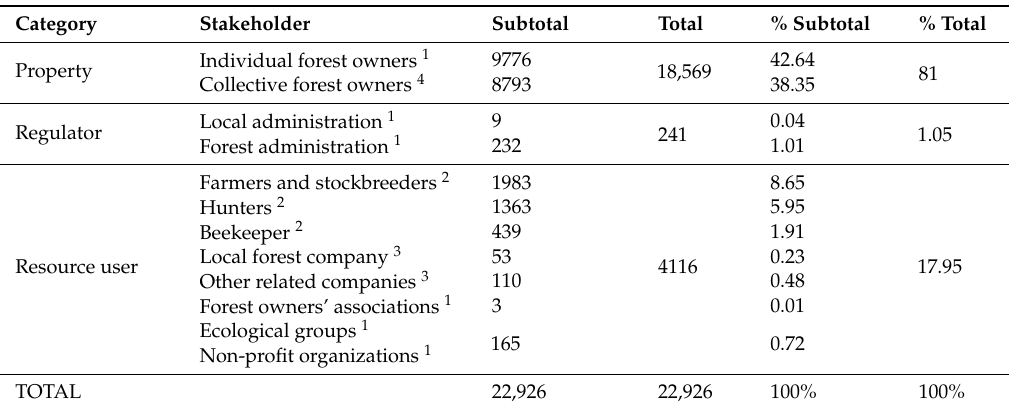
Table 2. Initial population by category and